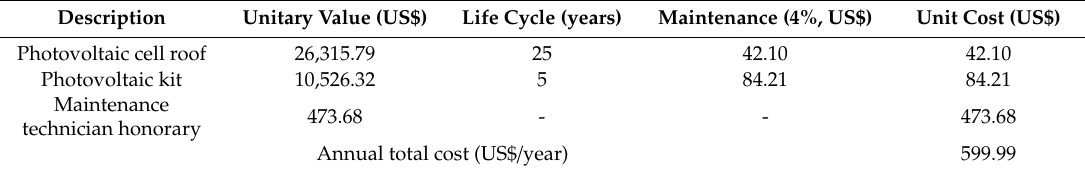
Table 8. Annual cost of photovoltaic system